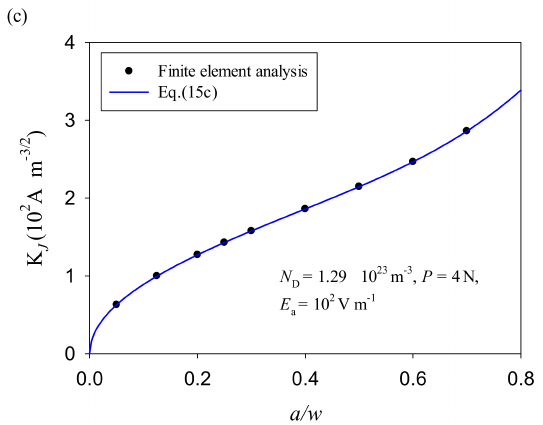
Figure 6. The fitted empirical formulae of the intensity factors of GaN PSCs, ( a ) stress intensity factor, ( b ) electric displacement intensity factor and ( c ) electric current intensity factor.